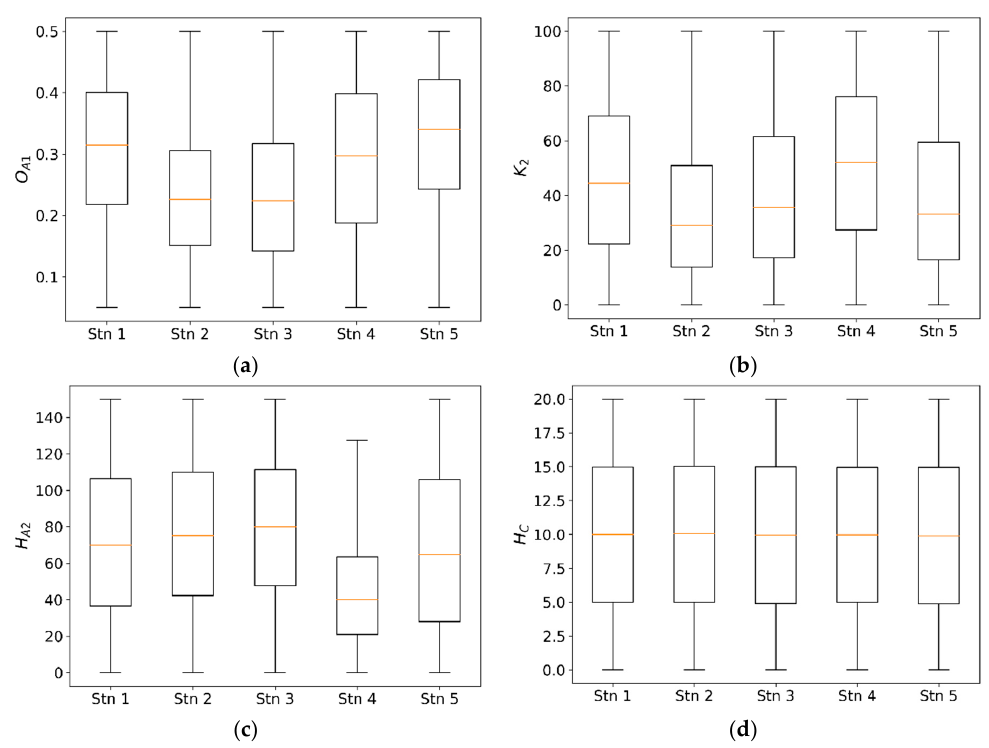
Figure 6. GLUE derived ranges of the four selected parameters across the five calibration stations (( a ) O A 1 , ( b ) K 2 , ( c ) H A 2 and ( d ) H C ).